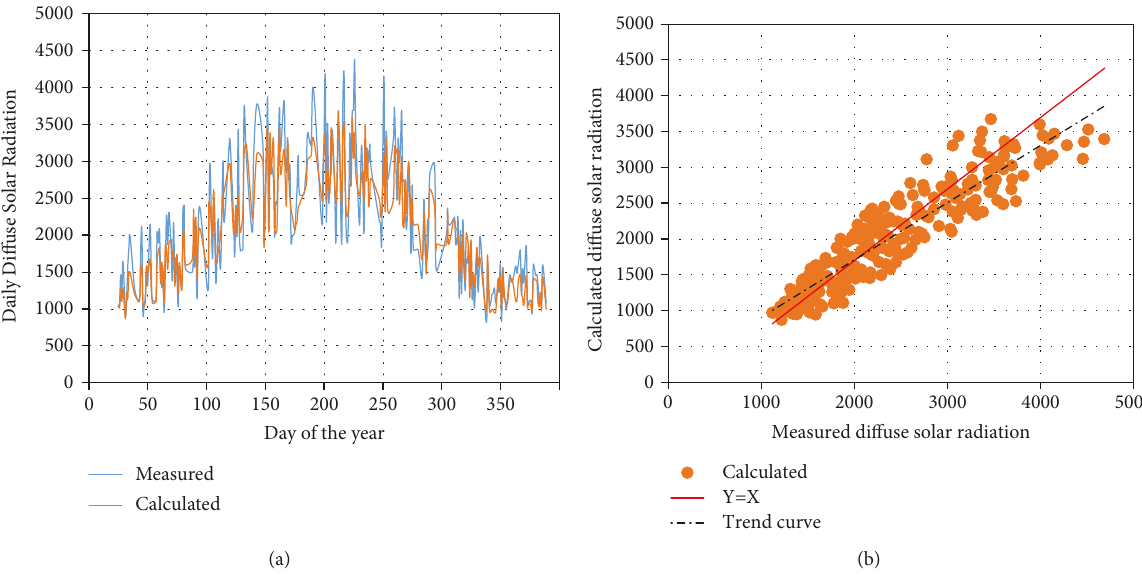
Figure 2: Comparison between measured and estimated values of di ff use radiation using the Collares-Pereira and Rabl ’ s